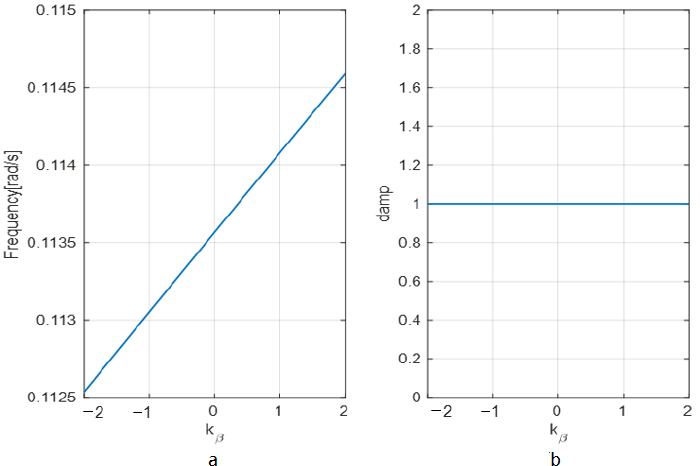
Figure 6. Curve of Influence of Moment Perturbation of Yaw Aerodynamic Stabilization on Pitching Channel Motion Mode: (a) frequency characteristic curve of the yaw channel motion mode under the perturbation of the yaw aerodynamic stability moment, (b) damping characteristic curve of the yaw channel motion mode under the perturbation of the yaw aerodynamic stability moment